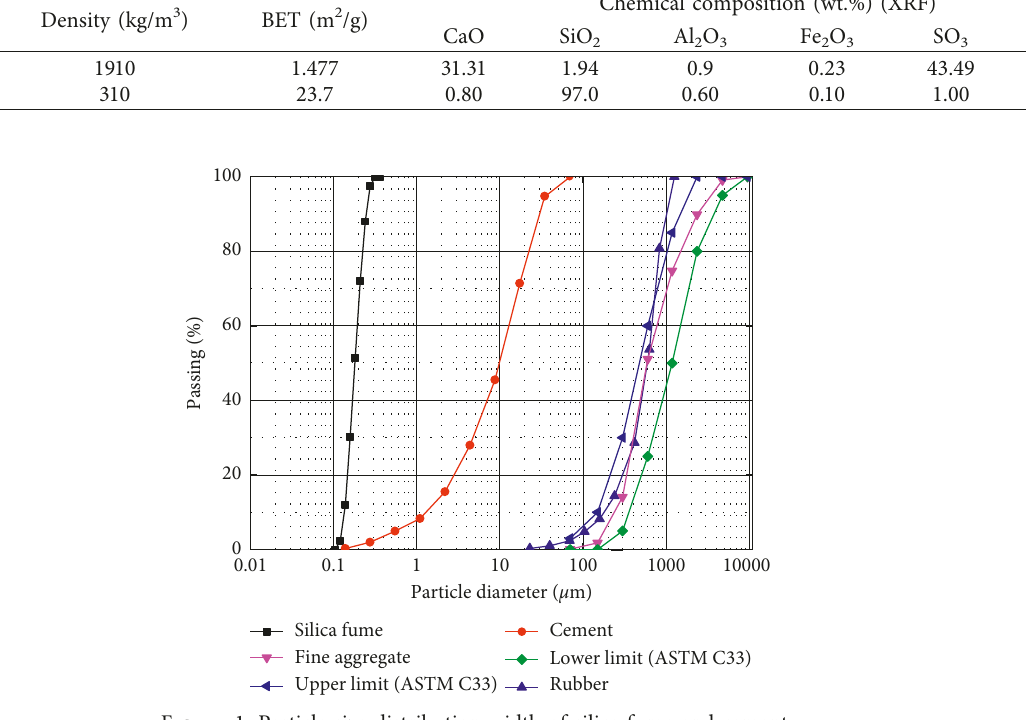
Figure 1: Particle size distribution width of silica fume and cement.